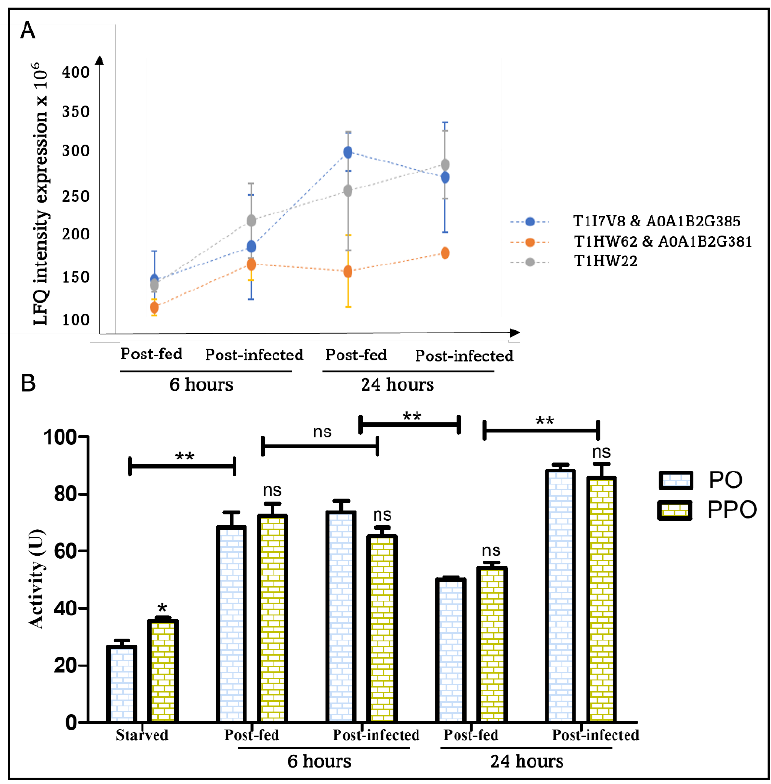
Figure 6. Effect of blood ingestion and T. cruzi development on PO and PPO expression and activity in R. prolixus hemolymph at 6 h and 24 h post-challenge. ( A ) Profile plot representing the LFQ expression intensity of POs/PPOs isoforms under blood-fed and T. cruzi ingestion showing insignificant variation of the protein expression ( n = 4); ( B ) Evaluation of PO and PPO activity in R. prolixus hemolymph from starved, blood-fed and infected insects. The results are expressed as the mean ± SEM ( n = 3), and statistical significance is shown by * (* p ≤ 0.05, ** p ≤ 0.01) calculated by unpaired t -test.